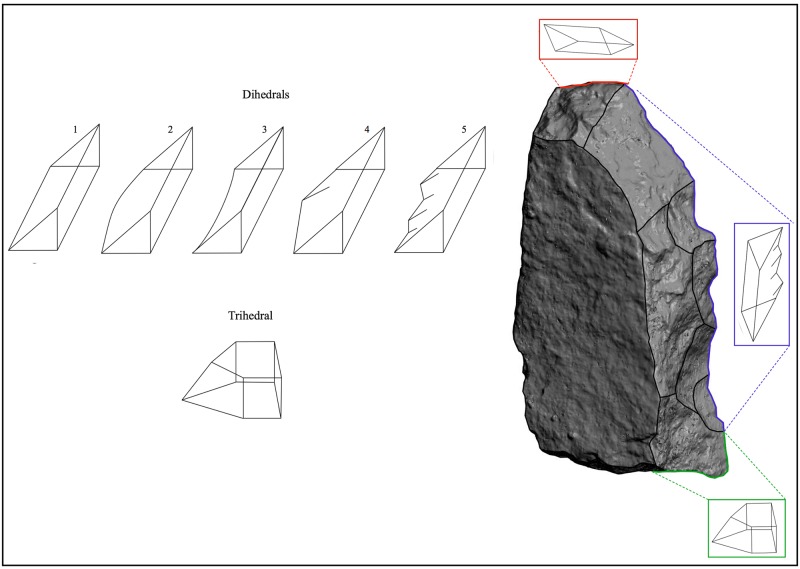
Working edge.(A) Geometry of working edge: Dihedral (edge with two planes) and Trihedral (edge with three planes). (B) Dihedrals delineations: 1) straight (not curved, flexed or scalloped line); 2) convex (curved outwards line); 3) concave (curved inwards line); 4) pointed (angular flexed line); 5) irregular (scalloped line).